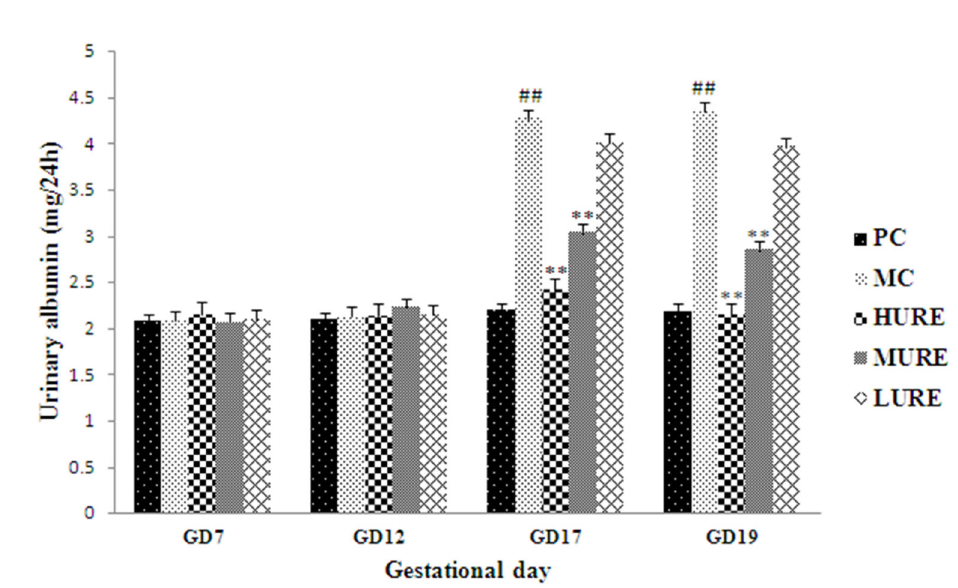
Figure 4. Uncaria rhynchophylla alkaloid extract (URE) ameliorated urinary albumin in the lipopolysaccharide (LPS)-induced preeclampsia- like rats. The 24-h urinary albumin was measured on gestational day (GD) 7, 12, 17, and 19. Data are reported as means ±